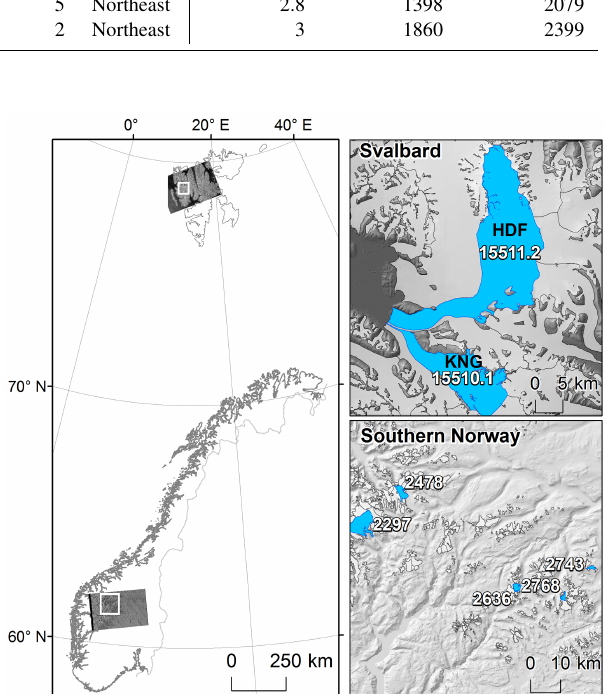
Figure 1. Study area in Svalbard (local IDs: 15511.2 is Holtedahl- fonna and 15510.1 is Kongsvegen) and southern Norway (local IDs: 2478 is Austdalsbreen, 2297 is Nigardsbreen, 2636 is Storbreen, 2768 is Hellstugubreen and 2743 is Gråsubreen) (Glacier outlines from Nuth et al., 2013; Andreassen et al., 2008; Paul et al.,